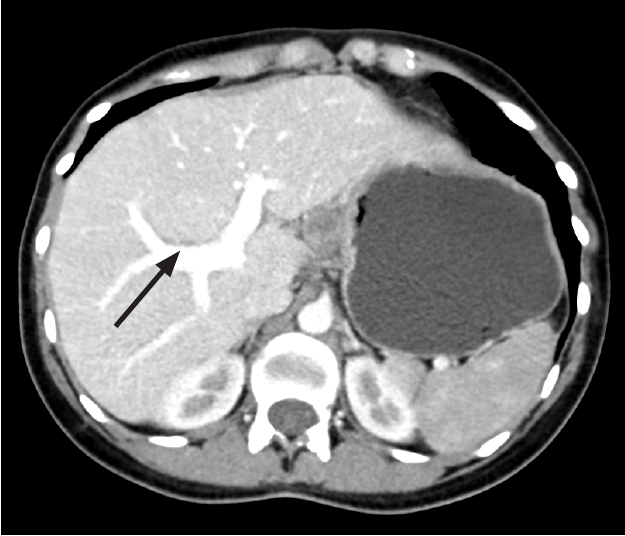
Fig 1. Axial CT scan showing normal branching pattern of portal